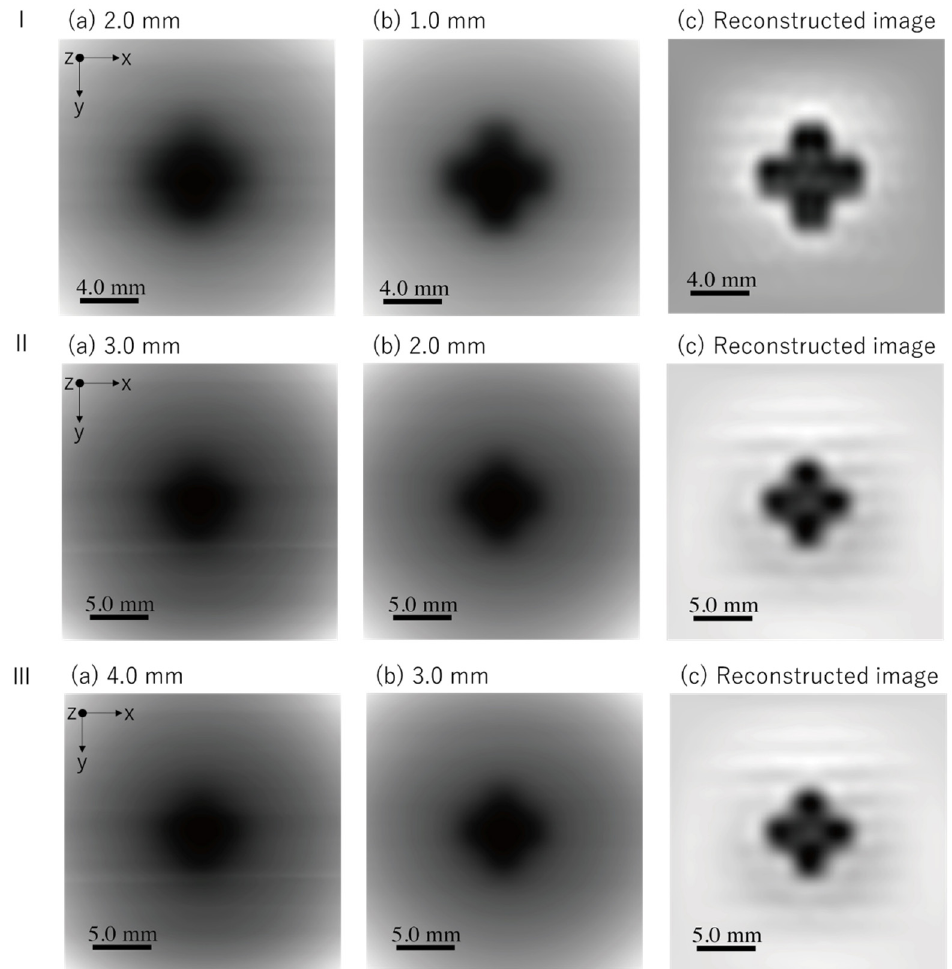
Figure 3. Two-dimensional magnetic particle distributions (I, II, and III): ( a , b ) measurement image; ( c ) reconstruction image based on ( a , b ).